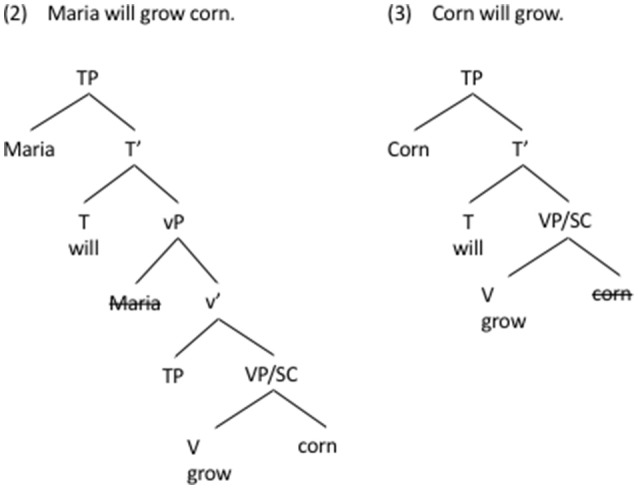
We present two sentences from English of varying degrees of syntactic elaboration. (2) illustrates a typical transitive TP (Tense Phrase), where each argument is generated in its own layer: the agent (Maria) in the vP layer, and the patient (corn) in the VP/SC layer. (3) is a hierarchically less complex, intransitive sentence, which lacks the agent and the vP layer.